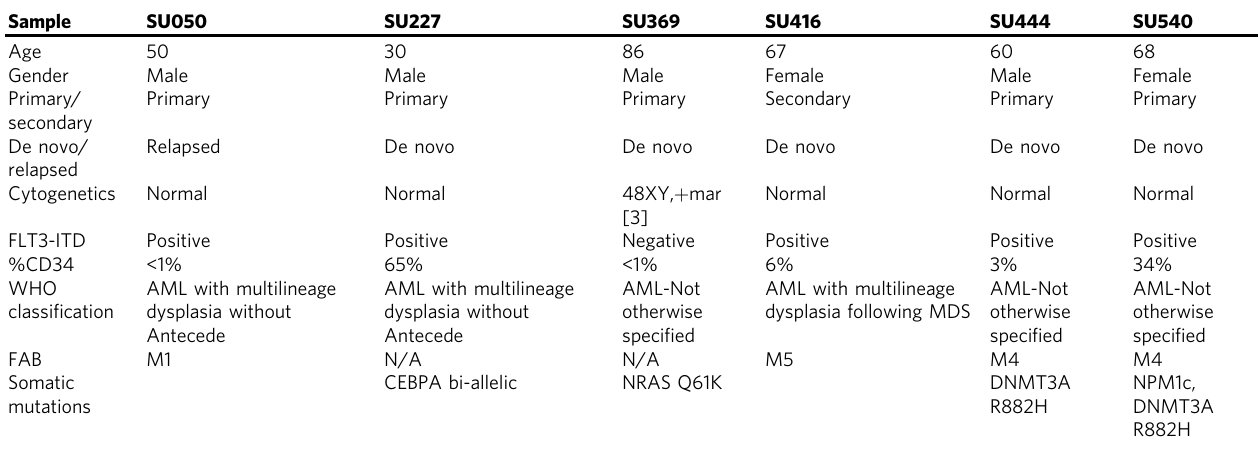
Table 1 Clinical and molecular characteristics of primary human AML samples analyzed in Fig. 6g